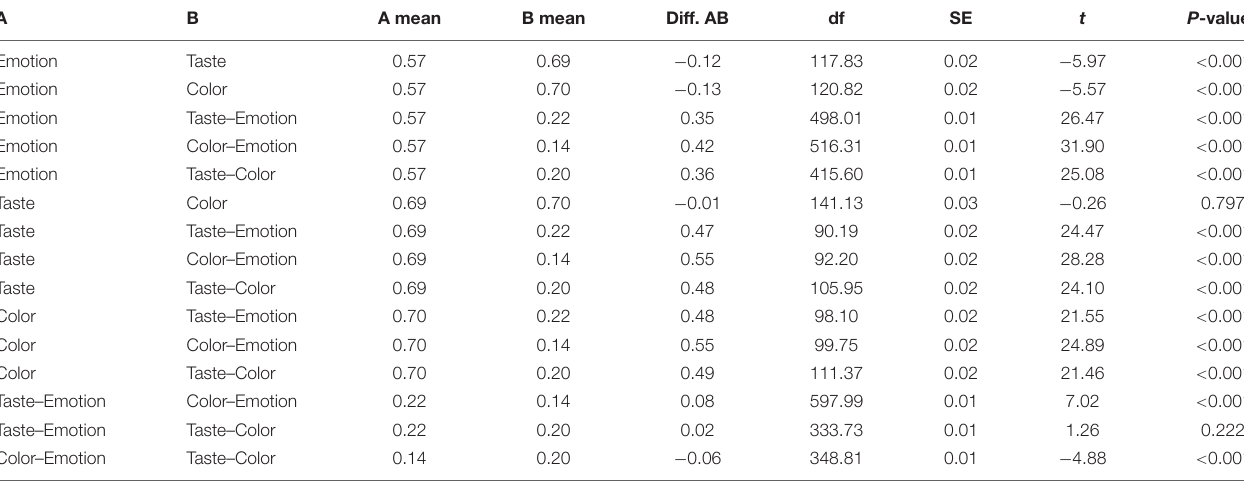
TABLE 1 | Comparison of semantic similarity across different concept